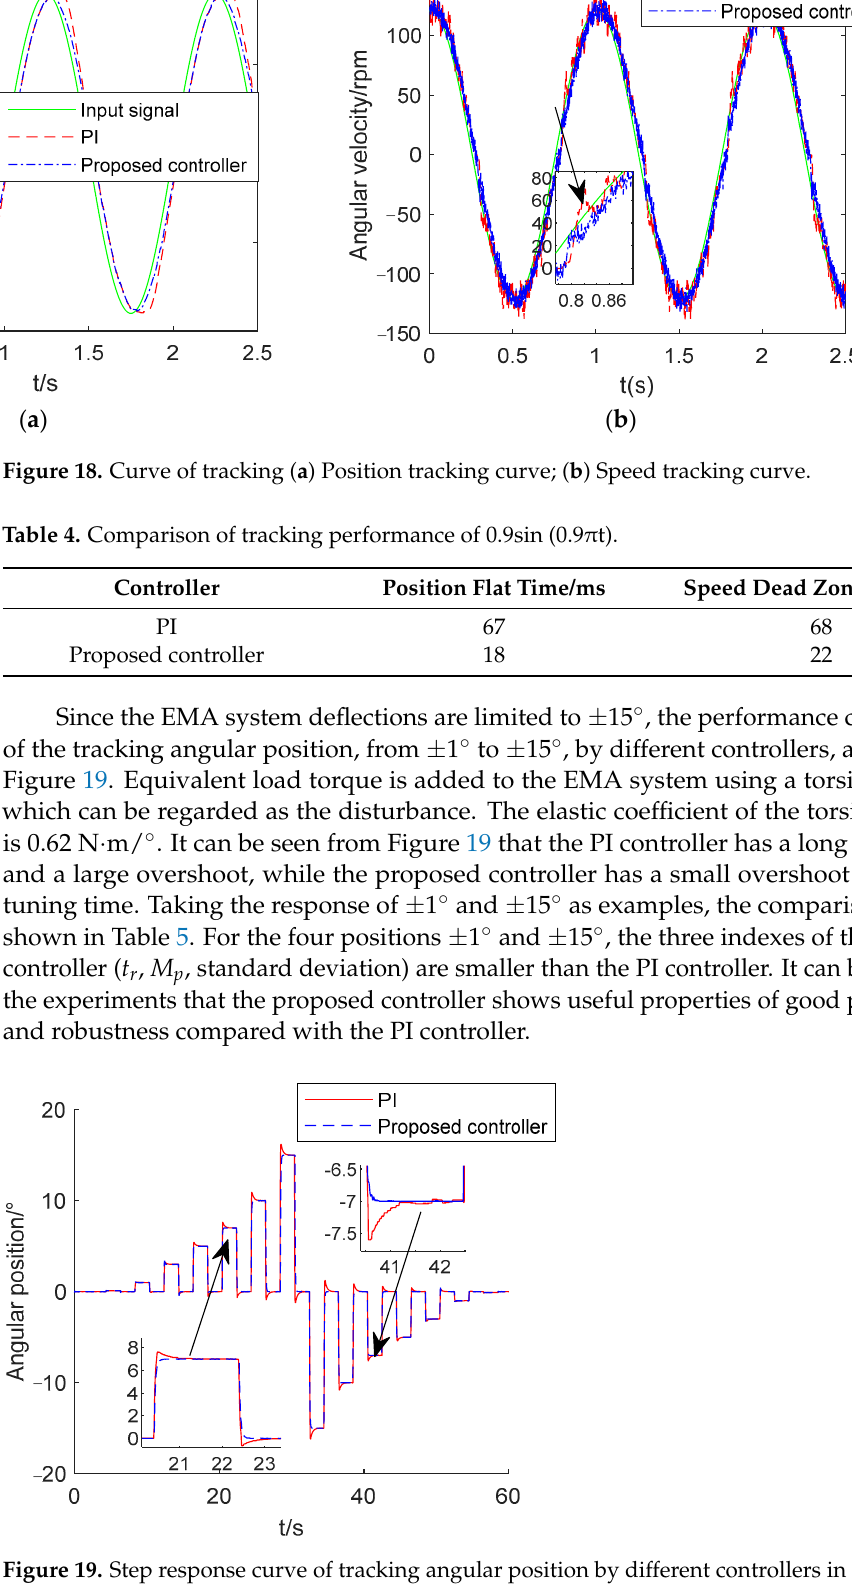
Figure 19. Step response curve of tracking angular position by different controllers in speed loop.